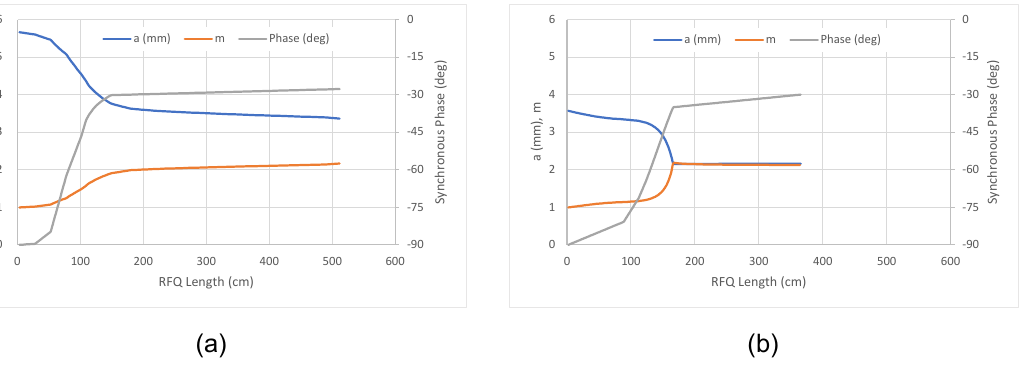
Figure 4. Evolutions of the synchronous phase (Phase in degree), aperture radius (a in mm) and modulation factor (dimensionless m) along RFQs: ( a ) 162.5 MHz design, ( b ) 325 MHz design. Both RFQs hold a Kilpatrick limit lower than 1.85 and a high energy gain per unit length. The cavity lengths are 5.18 m and 3.66 m, with synchronous phases of − 90.0°~ − 27.7° and − 90.0°~ − 30.0°, respectively. For 162.5 MHz RFQ design, the minimum aperture radius is 3.37 mm and the maximum modulation factor m is 2.17. Correspondingly, they are 2.16 mm and a factor of 2.16 in the 325 MHz RFQ design.